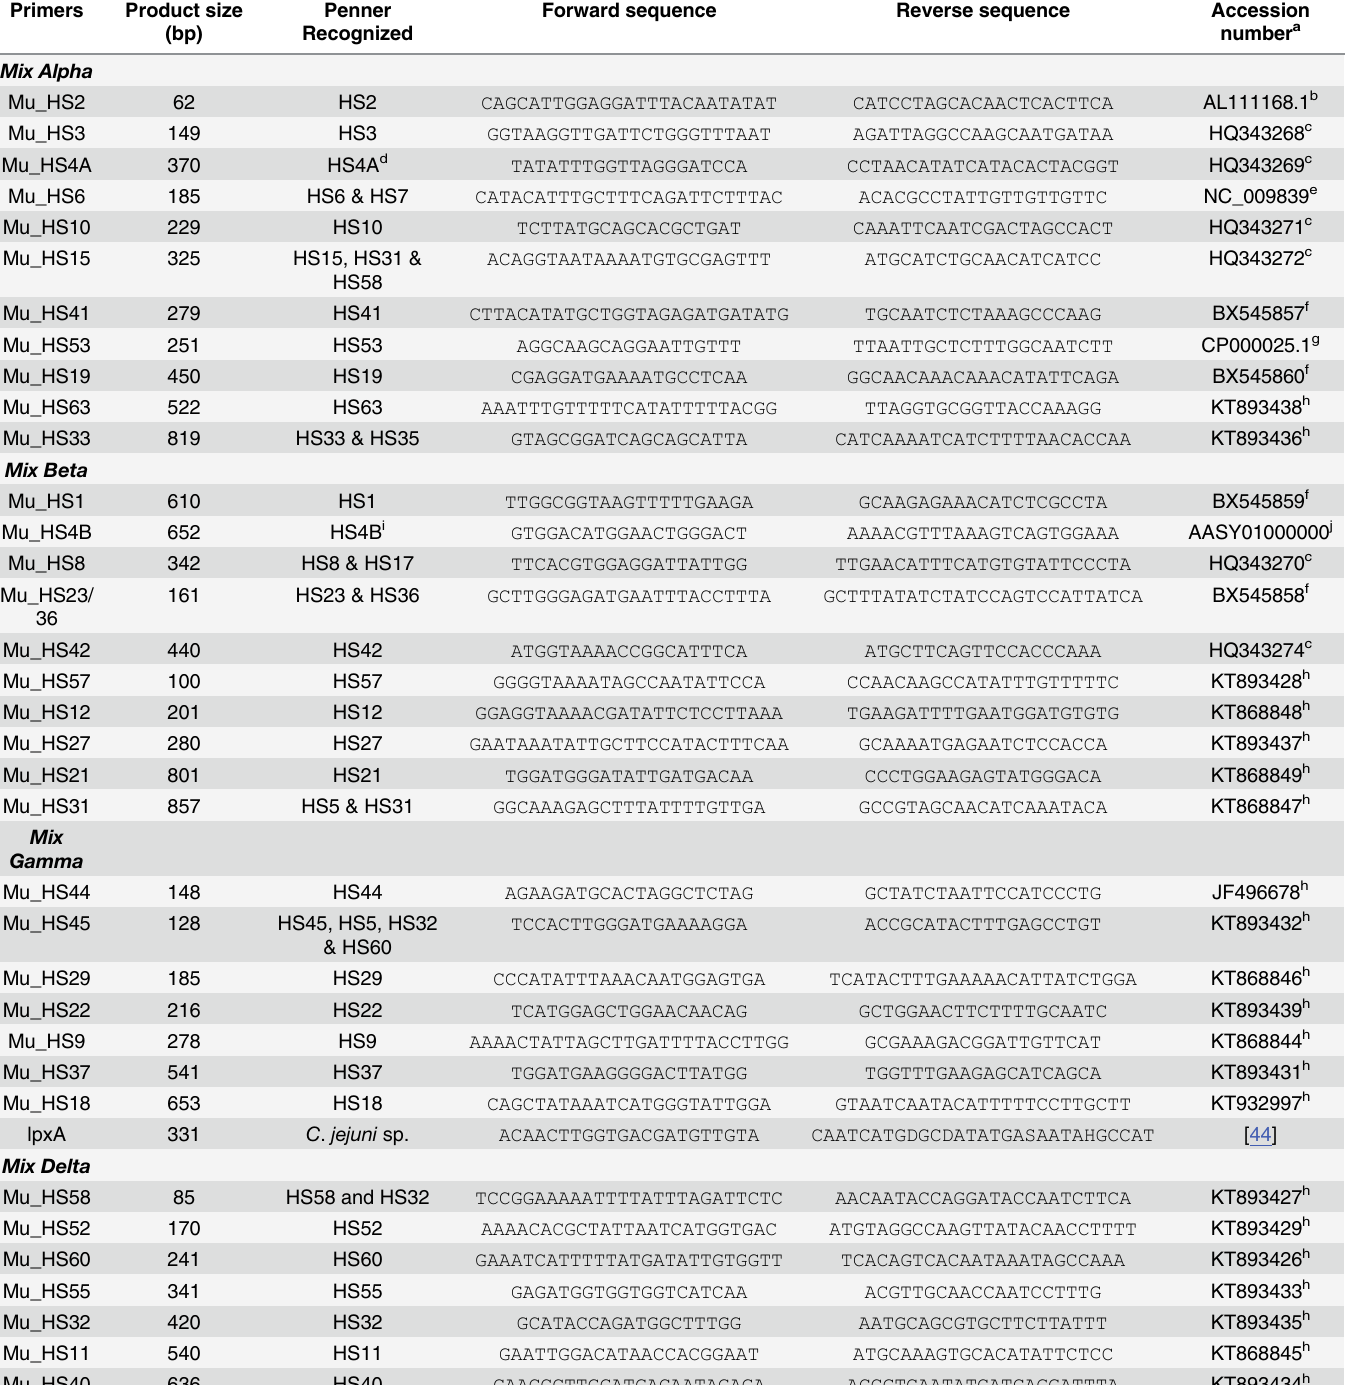
Table 3. Summary of the primer sequences included in the C . jejuni capsule multiplex typing